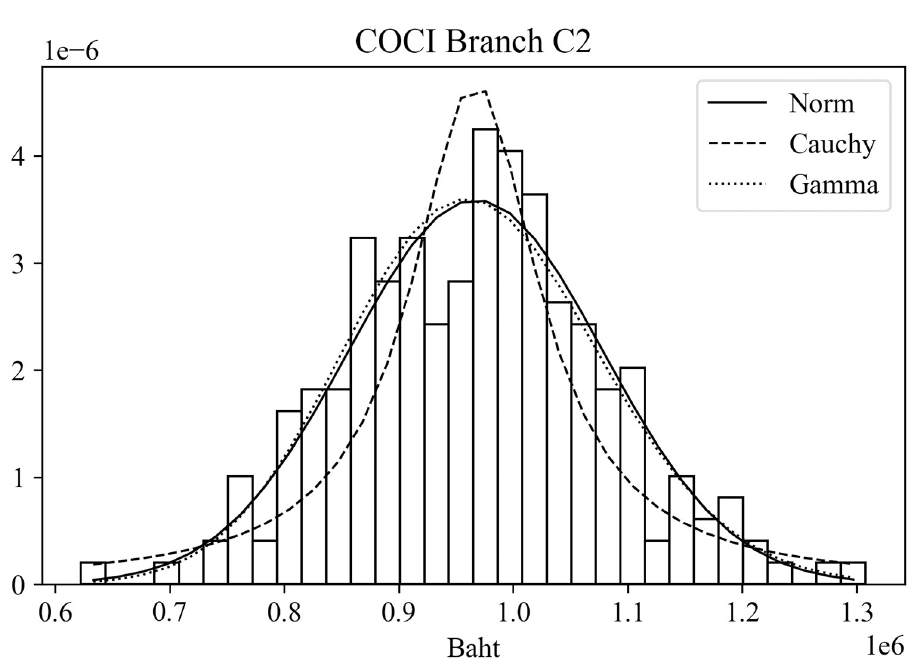
Fig 9. Examples of error distribution fitting results of